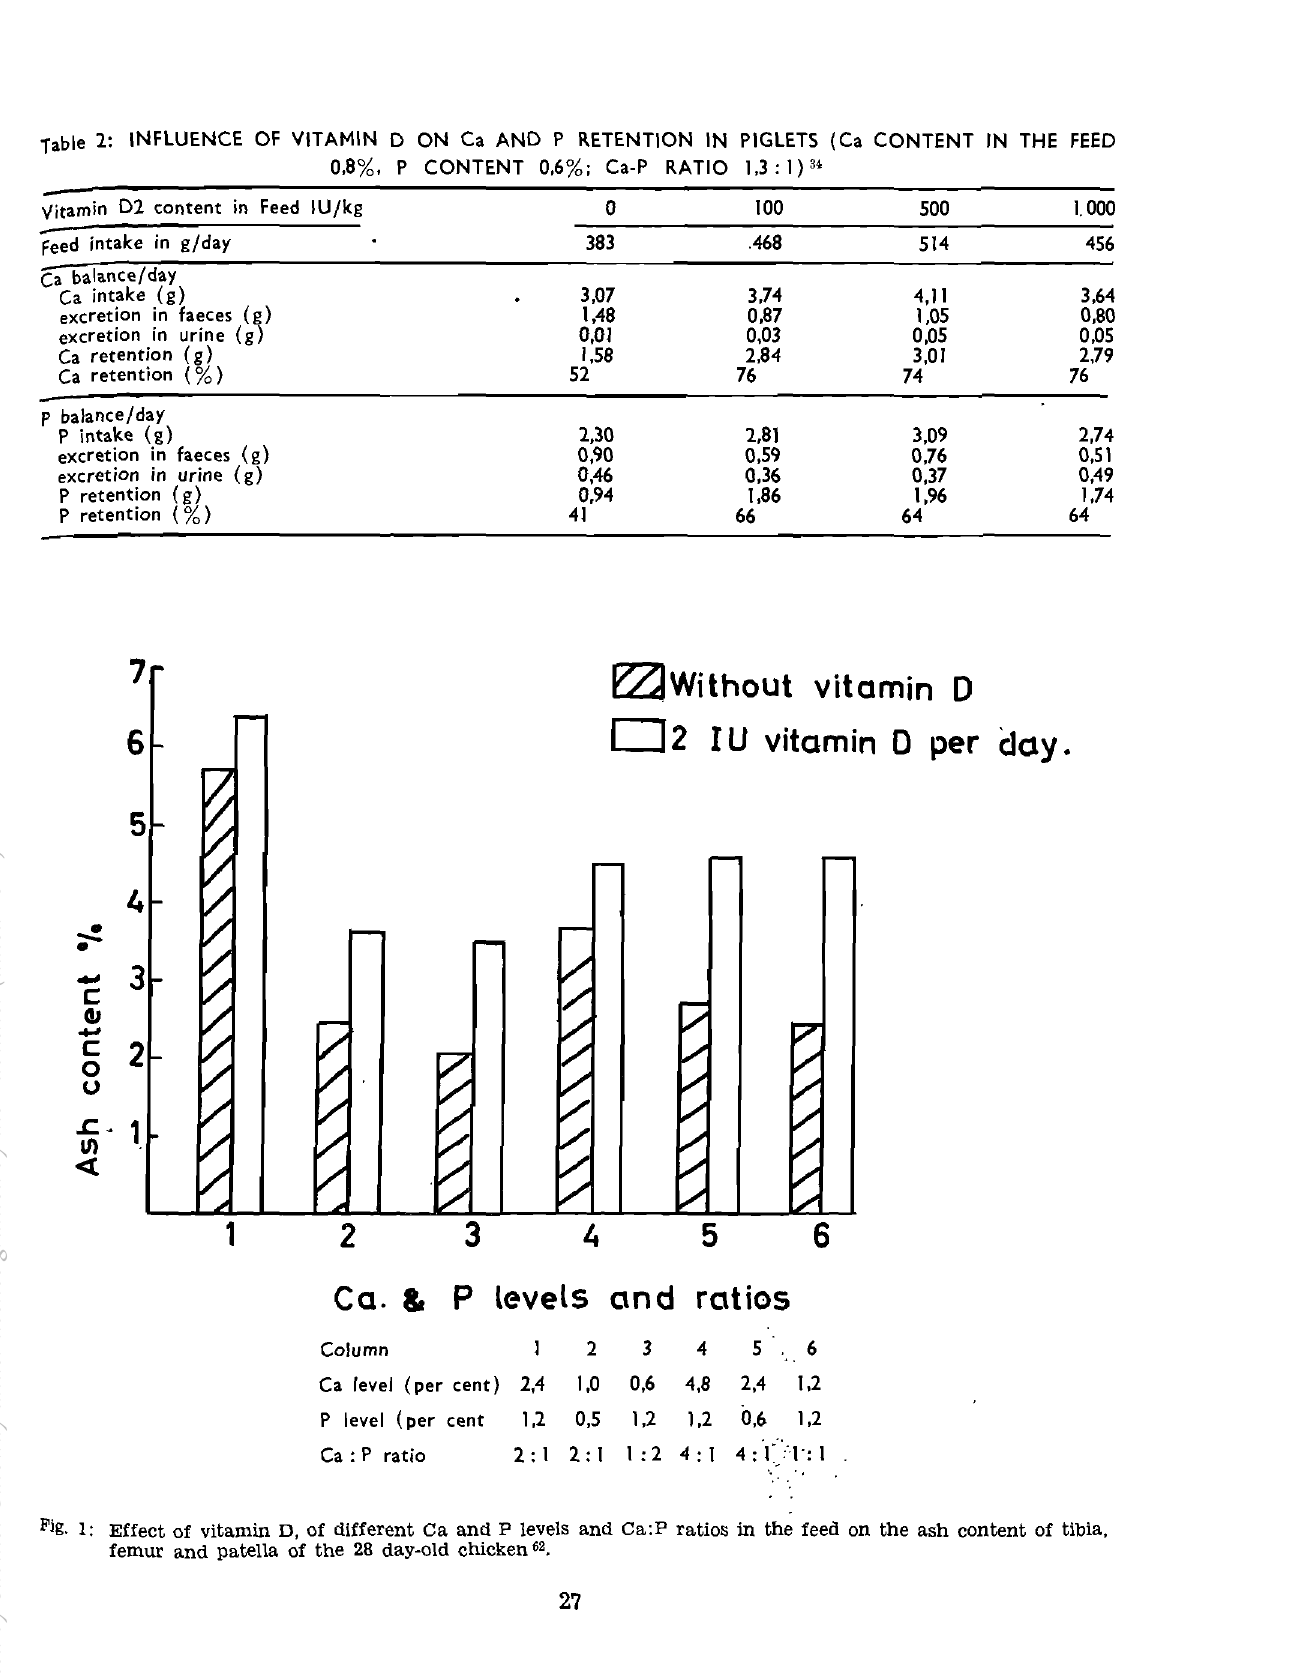
Fig, 1: Effect of vitamin D. of different Ca and P levels and Ca:P ratios in the feed on the ash content of tibia. femur and patella of the 28 day-old chicken